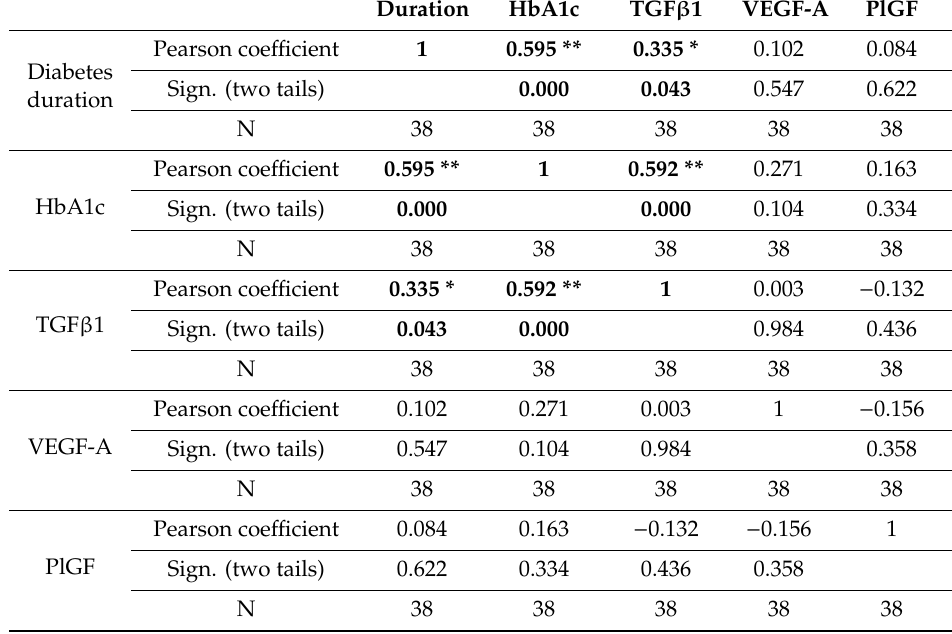
Table 3. Pearson correlation matrix of dependent variables. ** p < 0.01; * p < 0.05. Bold in order to further highlight statistically significant